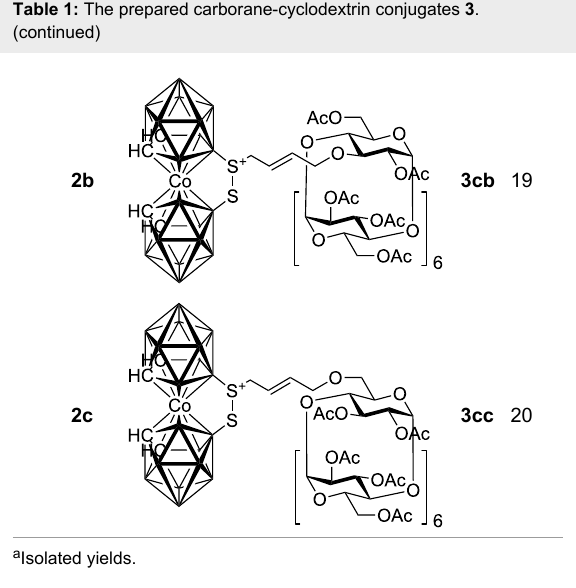
Table 1: The prepared carborane-cyclodextrin conjugates 3 . Reactants